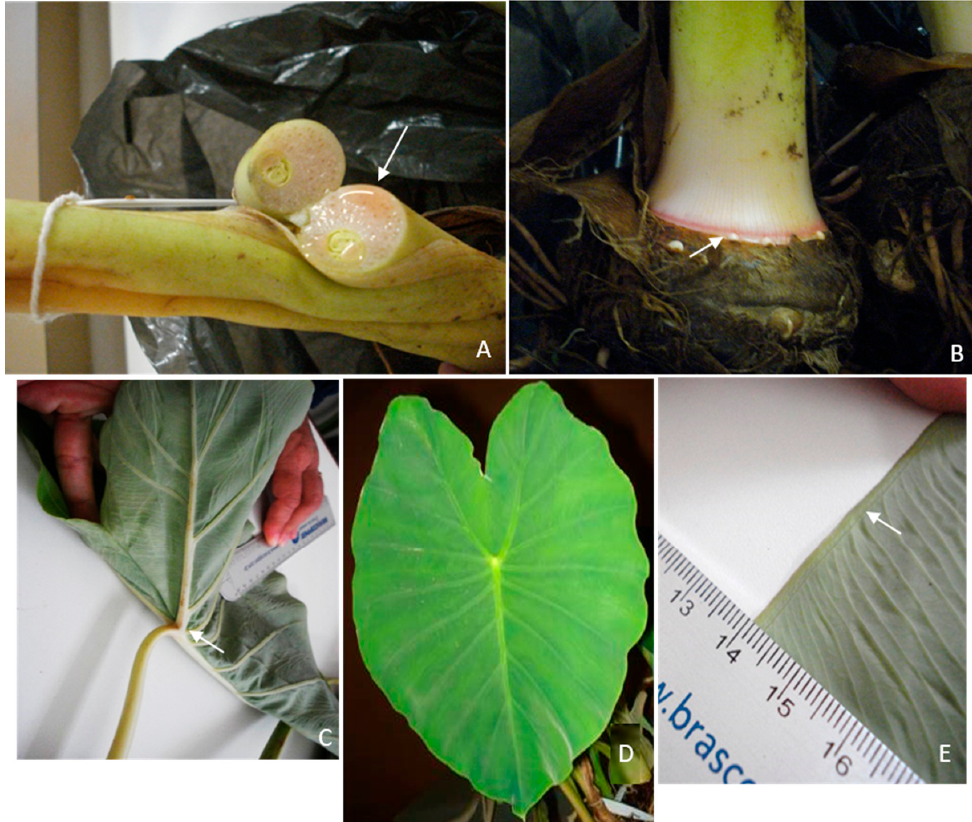
Figure 3. Images of C. esculenta . ( A ) The pink color of exudate in stem (arrow); ( B ) The pink color of the pseudostem (arrow); ( C ) The position of the petiole near the center of the leaf blade (arrow); ( D ) The upper leaf with a velvety texture; ( E ) the collecting vein (arrow). (Source: Laboratory of Plant Genetics/University of São Paulo, Campus of Ribeirão Preto, Brazil).